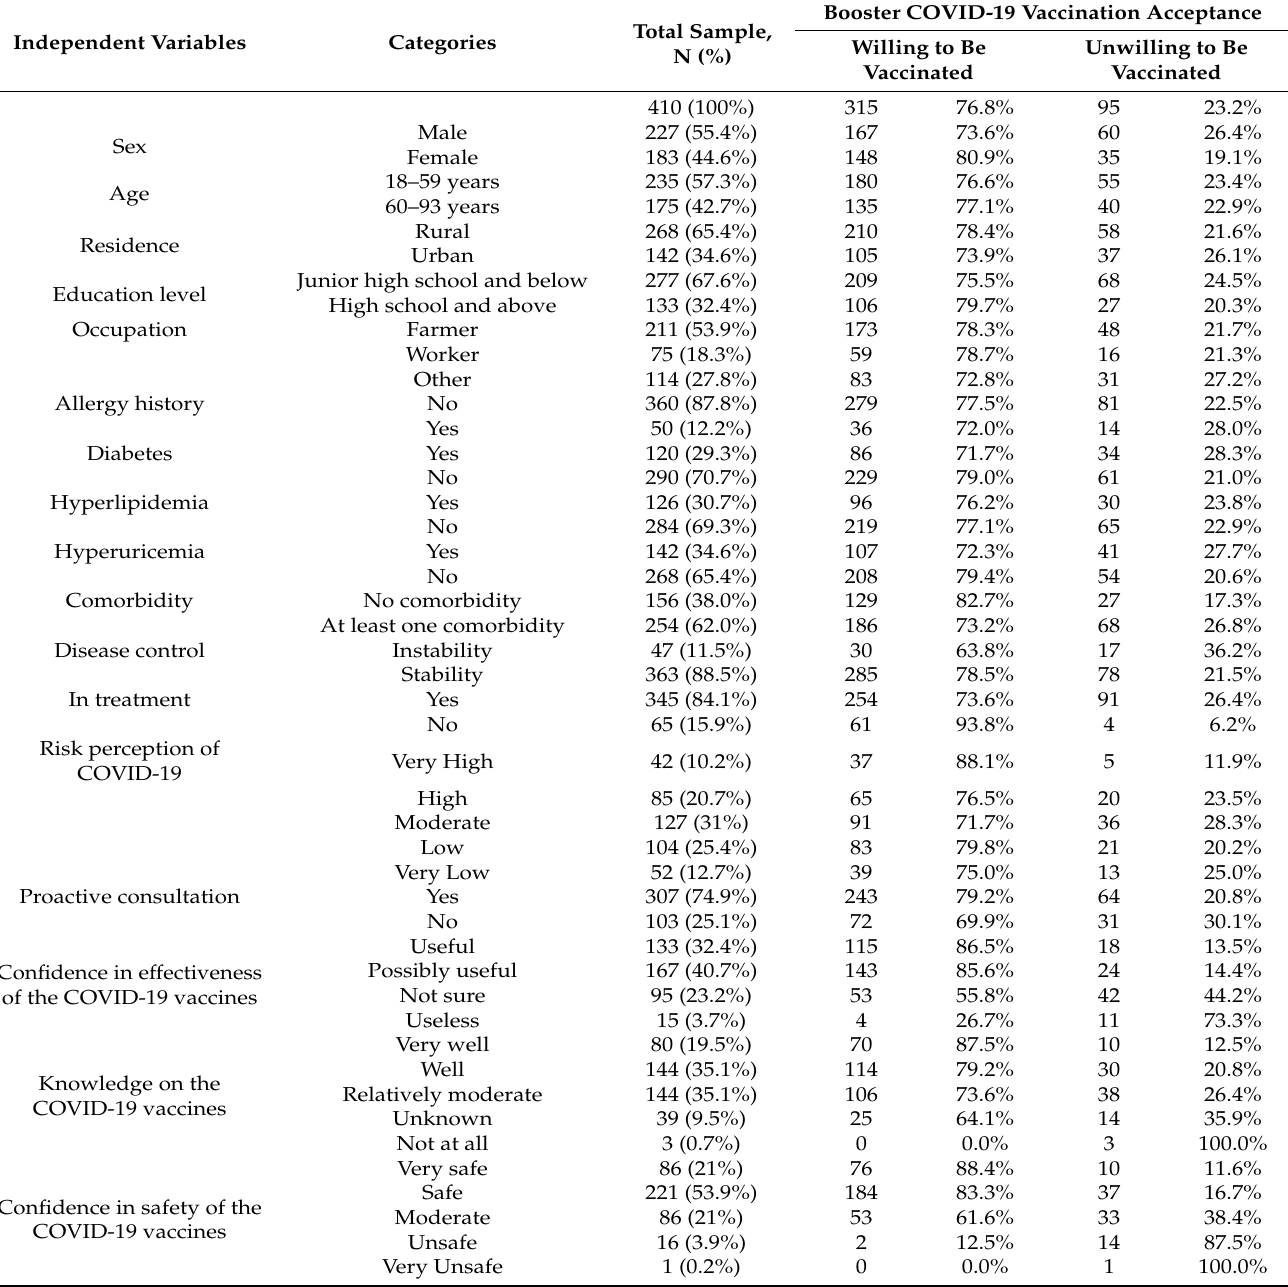
Table 1. Respondents’ characteristics, N =